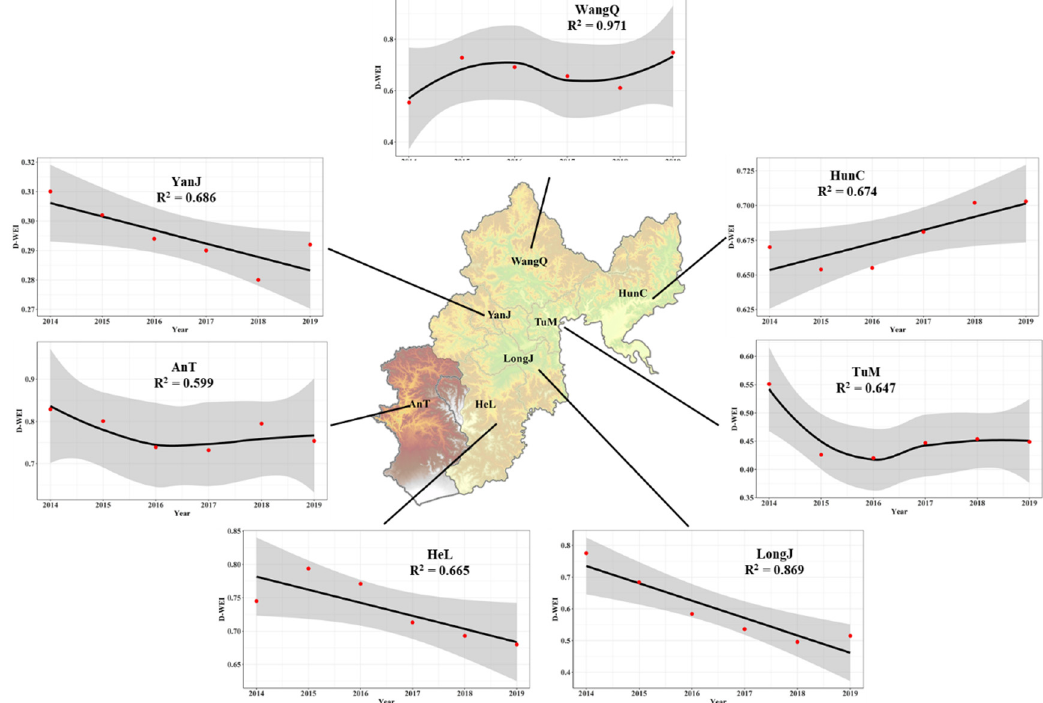
Figure 6. The trend of domestic water efficiency from 2014 to 2019.